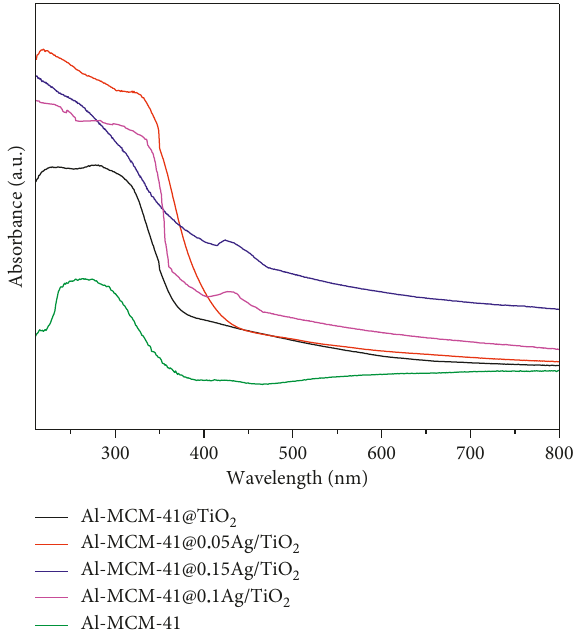
Figure 3: TEM images of Al-MCM-41@0 1Ag/TiO